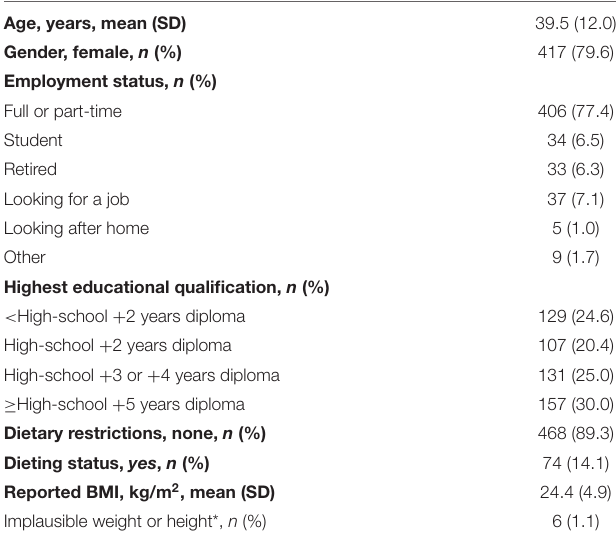
TABLE 1 | Participants’ characteristics in 2020, n =